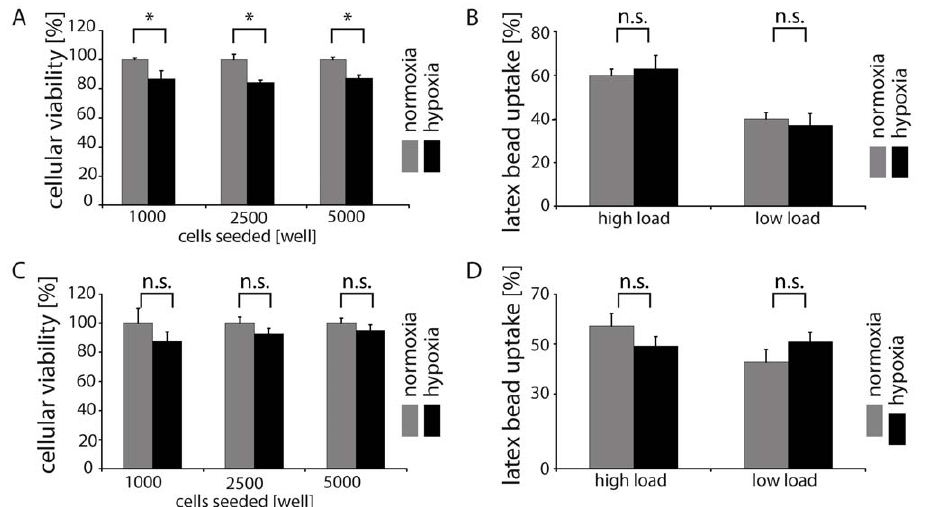
Figure 3. Hypoxia does not impact MEC function. Ben-Men-I cells and PMECs were incubated under limited oxygen conditions (1% O 2 ) and compared to cells cultivated under normoxia. Cellular viability was only slightly impacted by this treatment in Ben-Men-I (A – representative result shown of three independent experiments; error bars represent SD; Student’s t-test: p , 0.05, marked with *) but not significantly in PMECs (C, marked with n.s. for not significant). Evaluation of endocytotic activity by scoring fluorescent latex bead uptake did not reveal a significant difference after hypoxia in Ben-Men-I cells (B, marked with n.s. for not significant) or PMECs (D, marked with n.s. for not significant).